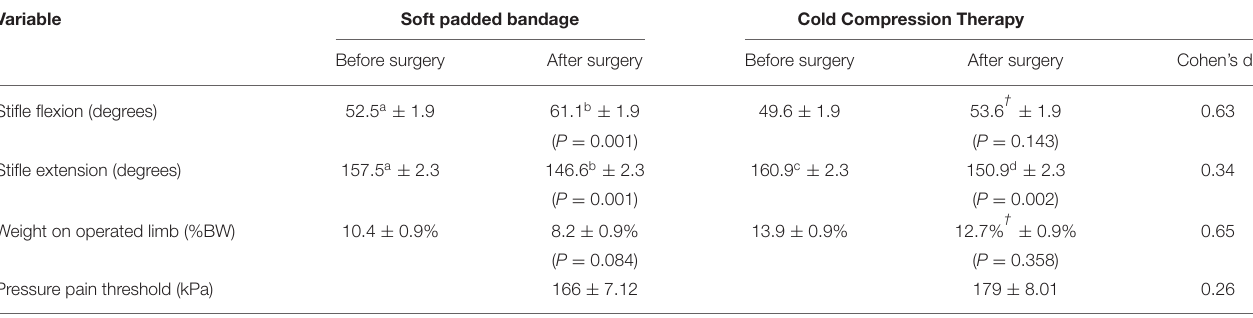
TABLE 1 | Least squared means ( ± SEM) joint motion and limb use before and after stifle joint surgery in 20 dogs undergoing stifle joint surgery treated with a soft padded bandage ( n = 10) or cold compression therapy ( n = 10). Variable Soft padded